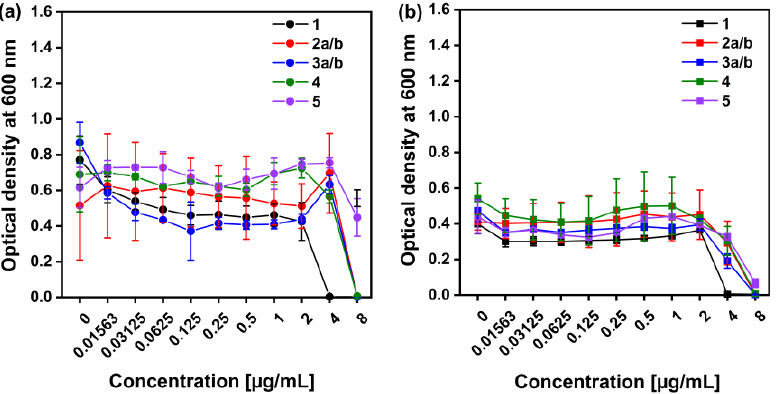
Figure 5. Antibacterial activity of different Re-ctz complexes against ( a ) S. aureus wild-type strain, and ( b ) S. aureus methicillin-resistant type strain, respectively. Table 2. Molecular docking results for the homological model MurG inhibitors 1 – 5 . Table 1. MIC and MBC values of Re-ctz complexes against S. aureus strains.